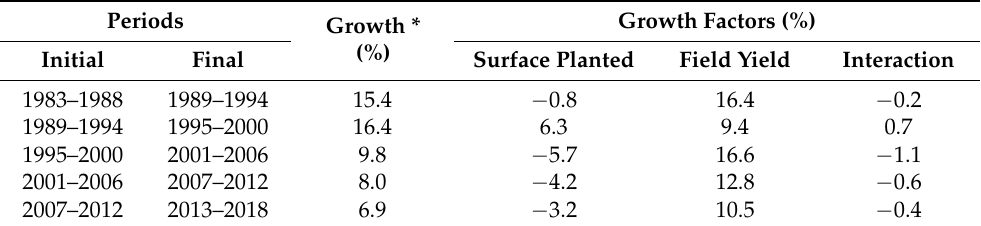
Table 5. Analysis of maize productivity in Mexico from1983 to 2018 obtained through the decompo- sition of production growth factors of the population. Periods Growth * Growth Factors (%) (%)